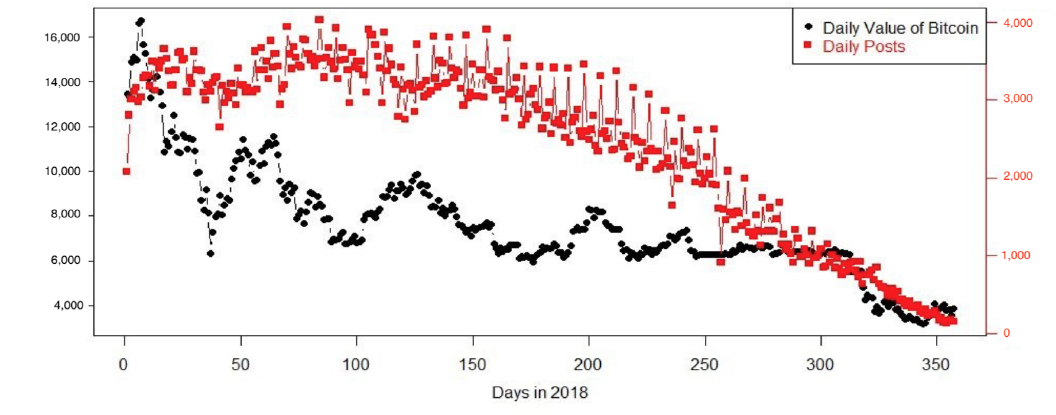
Figure 9. Nominal comparison between the daily number of posts and the closing value in 2018.